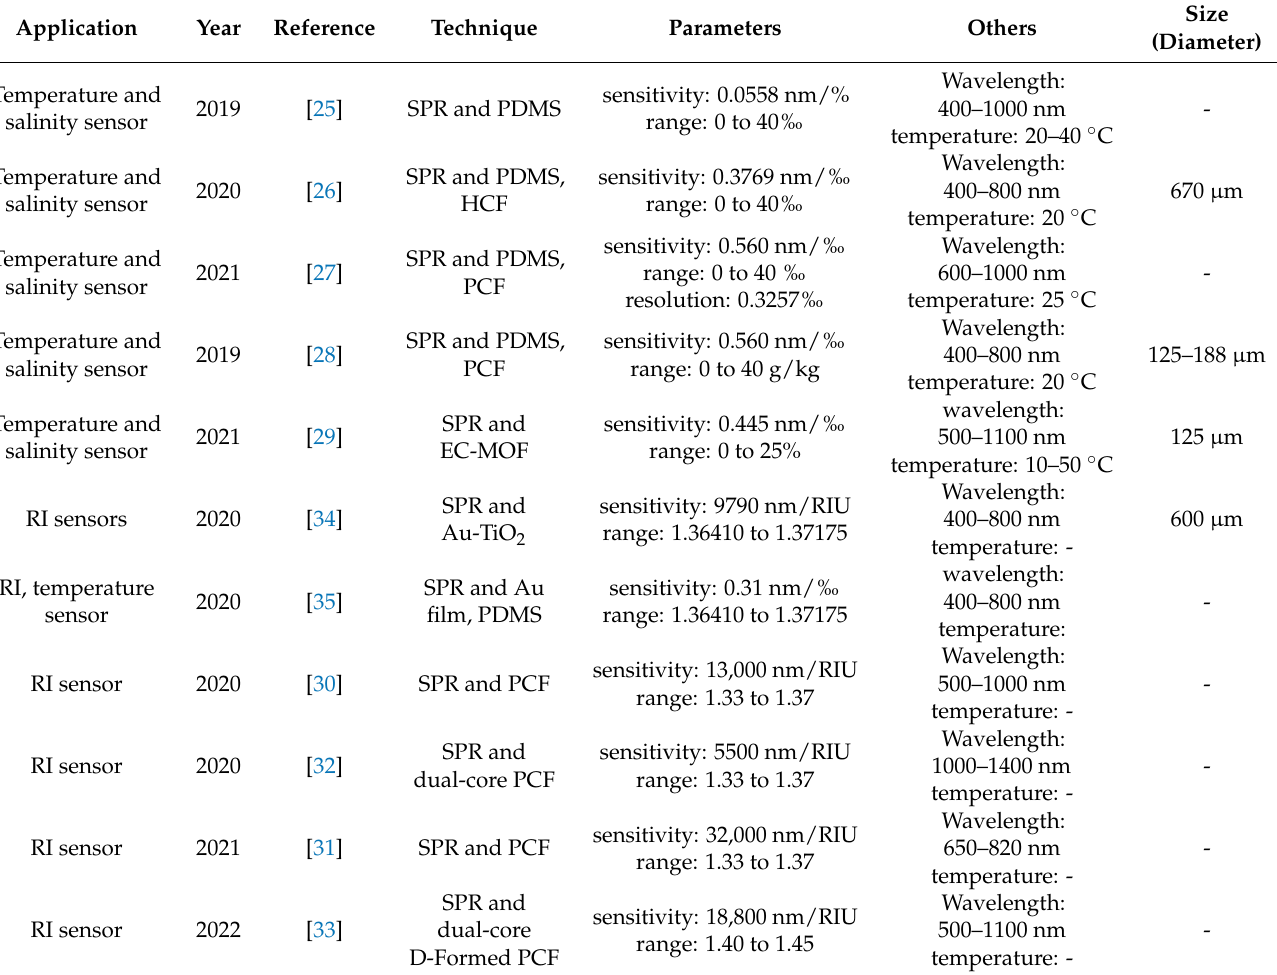
Table 1. Summary of optical fiber SPR